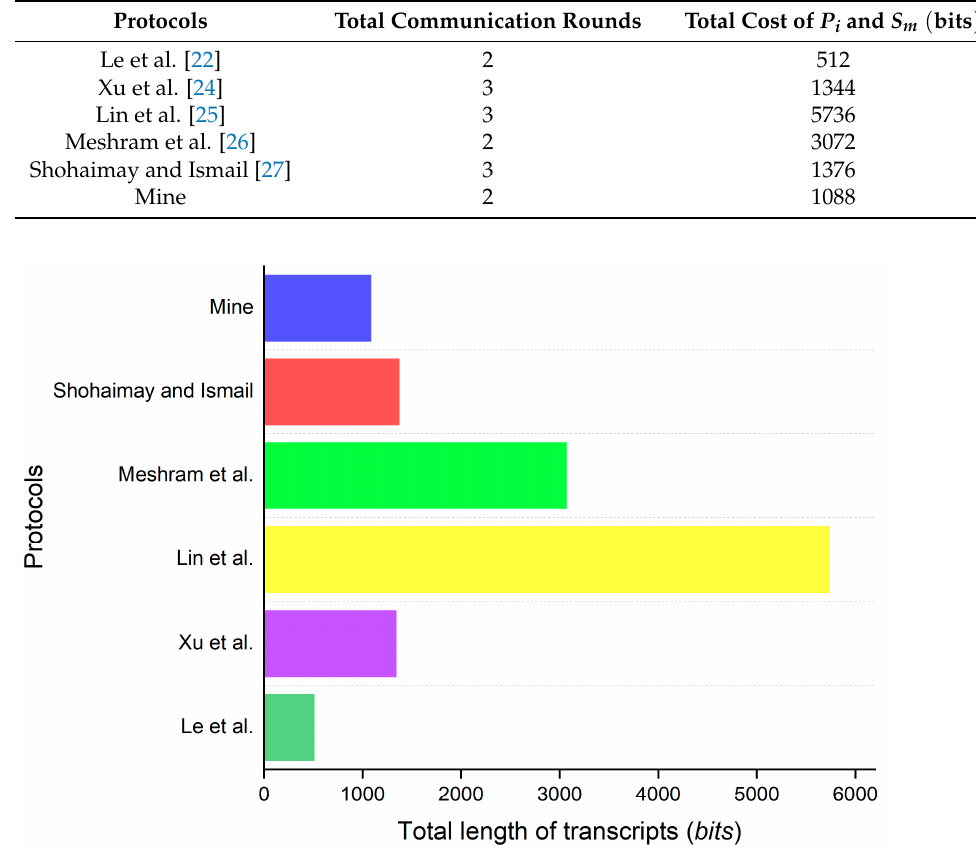
Figure 5. Total length of transcripts of different protocols [22,24–27].